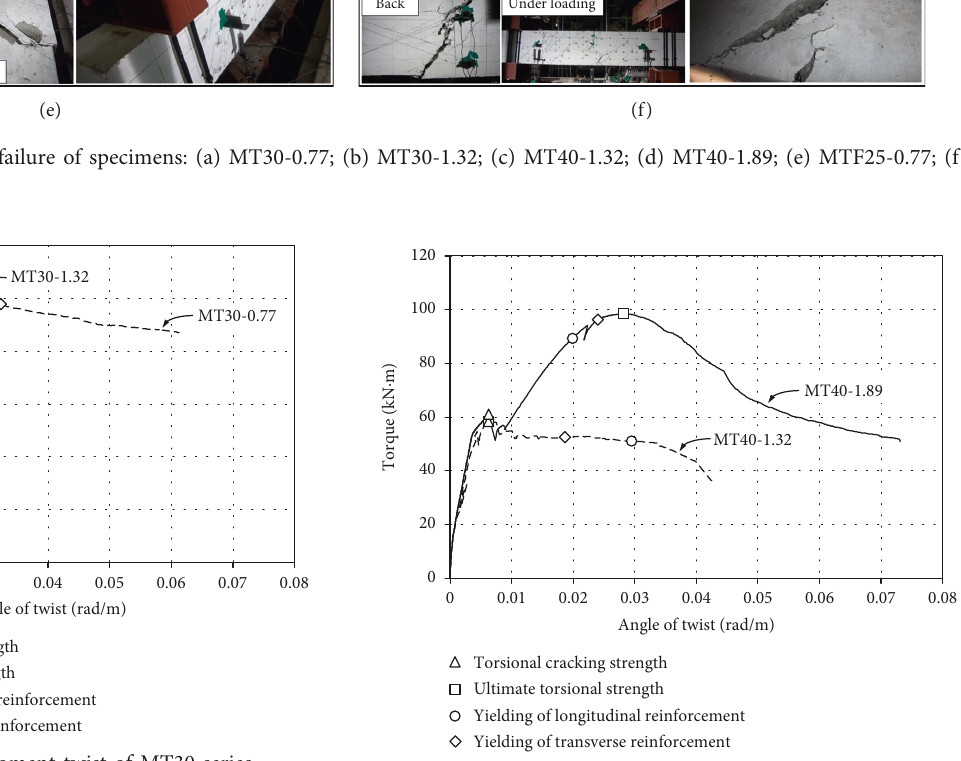
Figure 5: Torsional moment-twist of MT40